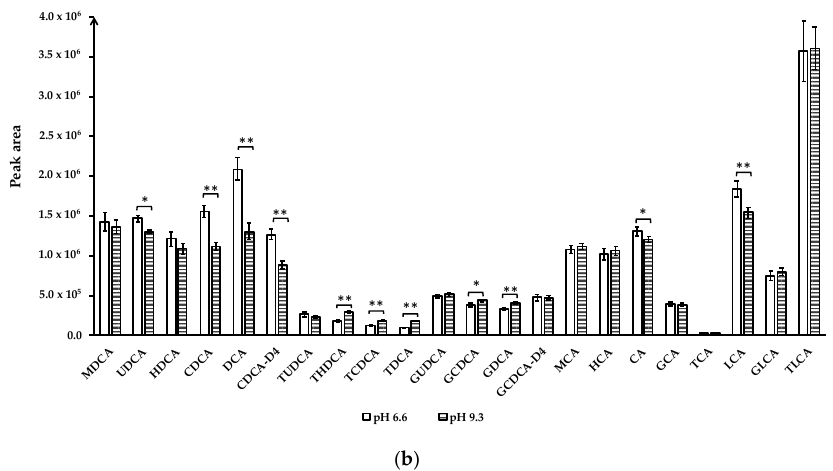
Figure 2. Effect of ammonium acetate concentration and mobile phase A (0.01% formic acid in water) pH on bile acids peak area. ( a ) Ammonium acetate concentration; ( b ) mobile phase A pH. Data for ammonium acetate concentration at 1 mM, 10 mM and mobile phase A pH 3.8 not shown due to co-elution of TUDCA and THDCA. Data shown as mean and standard error of mean based on three measurements. * p < 0.05, ** p < 0.01. Abbreviations: murideoxycholic acid (MuriDCA), ursodeoxycholic acid (UDCA), hyodeoxycholic acid (HDCA), chenodeoxycholic acid (CDCA), deoxycholic acid (DCA), chenodeoxycholic acid-d4 (CDCA-d4), tauroursodeoxycholic acid (TUDCA), taurohyodeoxycholic acid (THDCA), taurochenodeoxycholic acid (TCDCA), taurodeoxycholic acid (TDCA), glycoursodeoxycholic acid (GUDCA), glycochenodeoxycholic acid (GCDCA), glycodeoxycholic acid (GDCA), glycochenodeoxycholic acid-2,2,4,4-d4 (GCDCA-d4), β -muricholic acid ( β -MCA), hyocholic acid (HCA), cholic acid (CA), glycocholic acid (GCA), taurocholic acid (TCA), lithocholic acid (LCA), glycolithocholic acid (GLCA), taurolithochoic acid (TLCA).